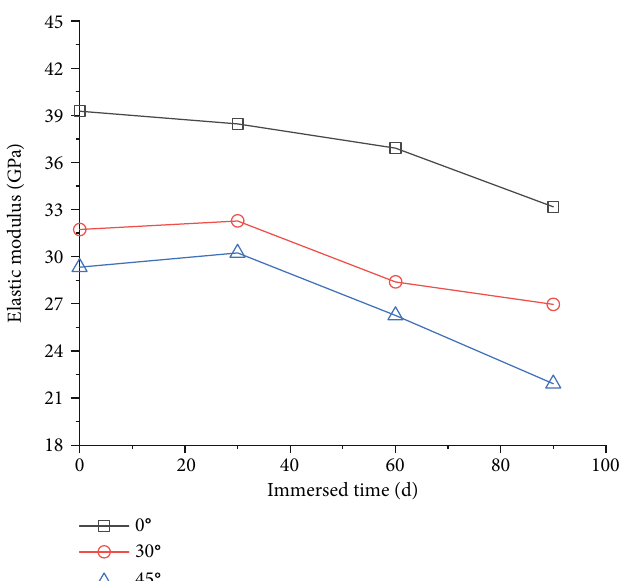
Figure 12: Variation of elastic modulus of fi ssured granite with α = 0 ° , 30 ° , and 45 ° after chemical corrosion for 30, 60, and 90 days.